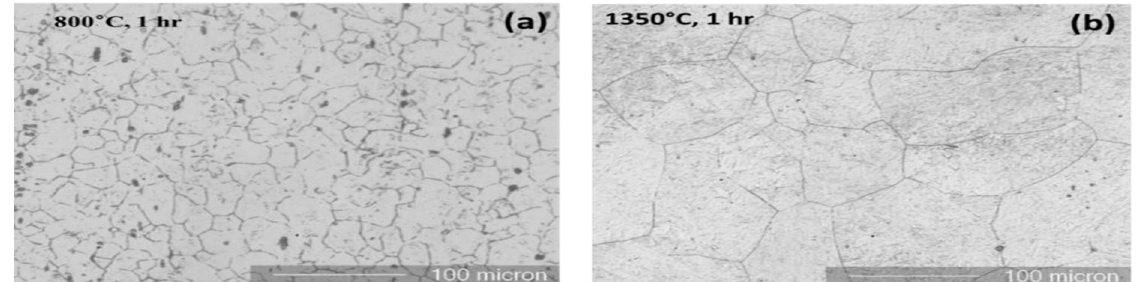
Fig. 4: Optical Micrographs of Sample-A at (a) 800°C and (b) 1350 o C